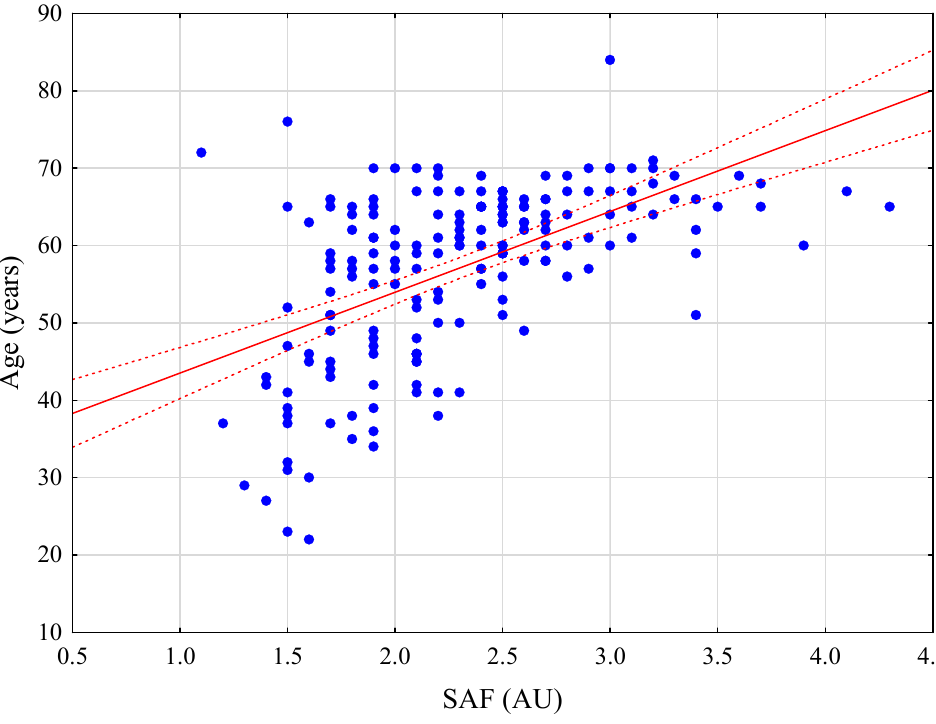
Figure 1. Correlation between skin autofluorescence (SAF) and age.